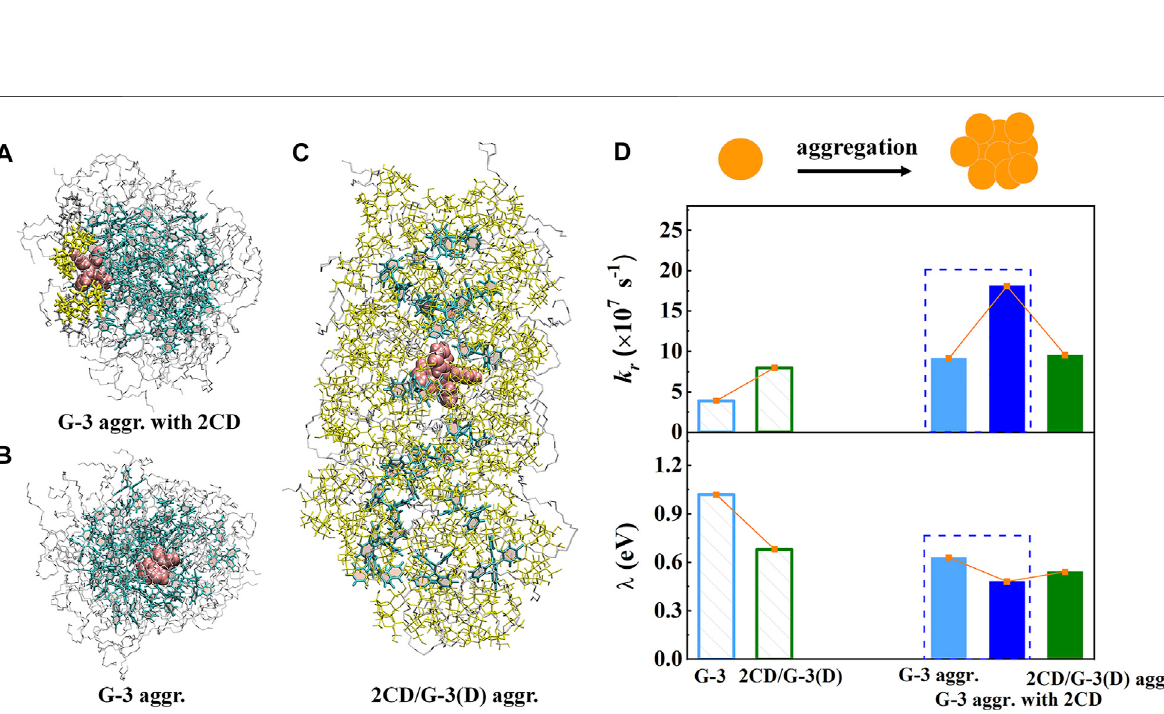
Frontiers in Chemistry |